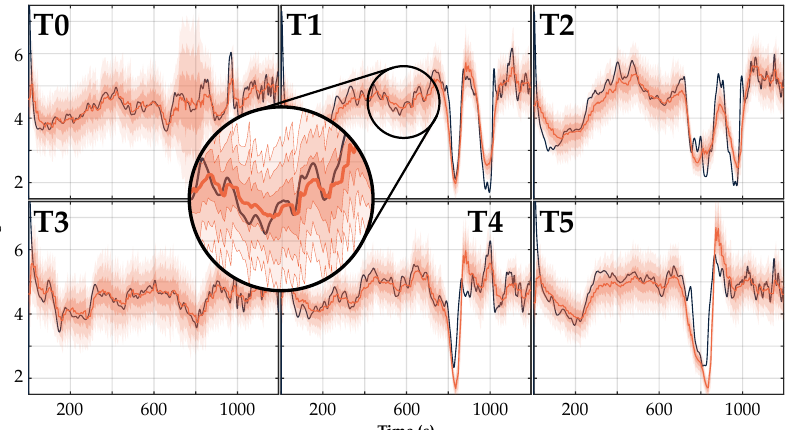
Figure 12. Power generated from six of the nine turbines. This reduction was made as the other turbines are mostly in free stream conditions and do not add more information. The black line depicts the SOWFA simulation as a reference, orange shows the EnKF estimate including 1,2 and 3 standard deviation boundaries. As the wind direction changes from t = 600 s to 900 s, T1, T2, T4 and T5 experience a reduction in wind speed due to the passing wakes. This leads to the sudden reduction in the generated power.